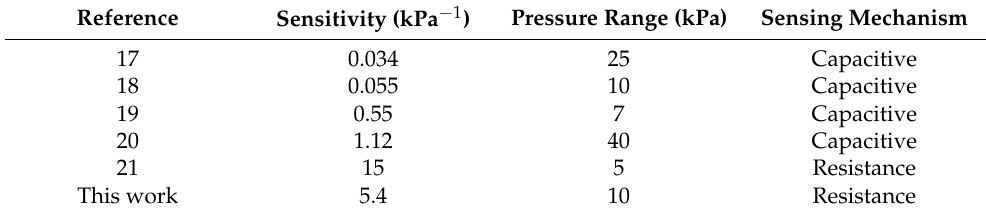
Table 1. Comparison of the sensitivity based on this work and previous